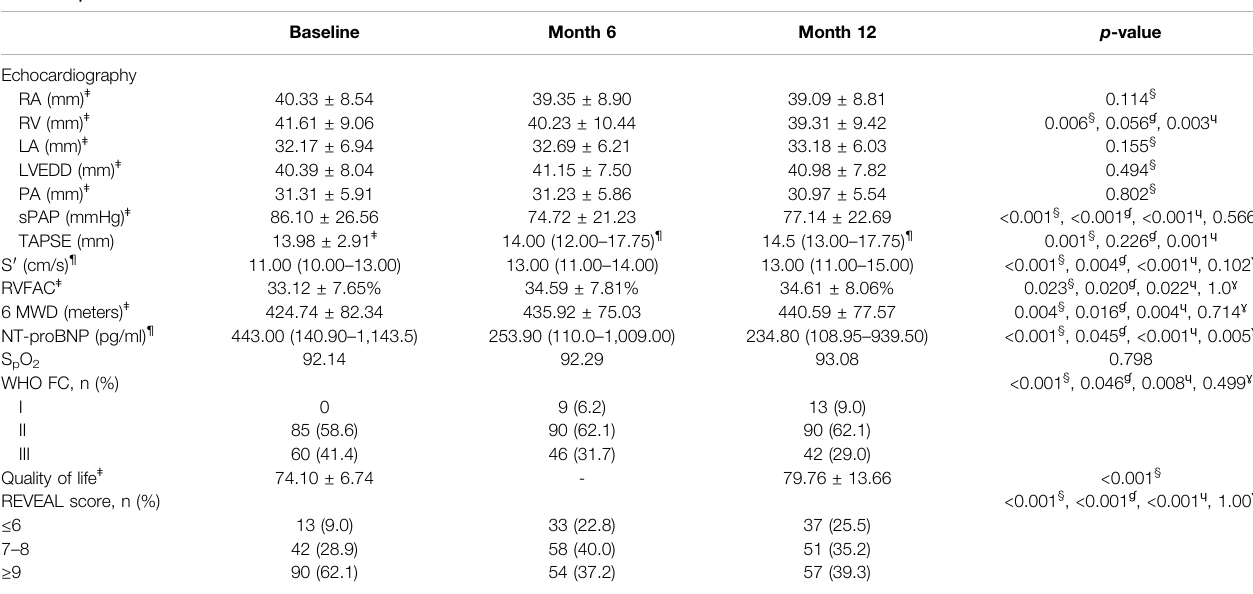
TABLE 3 | Parameters at the baseline and months 6 and 12 assessments.